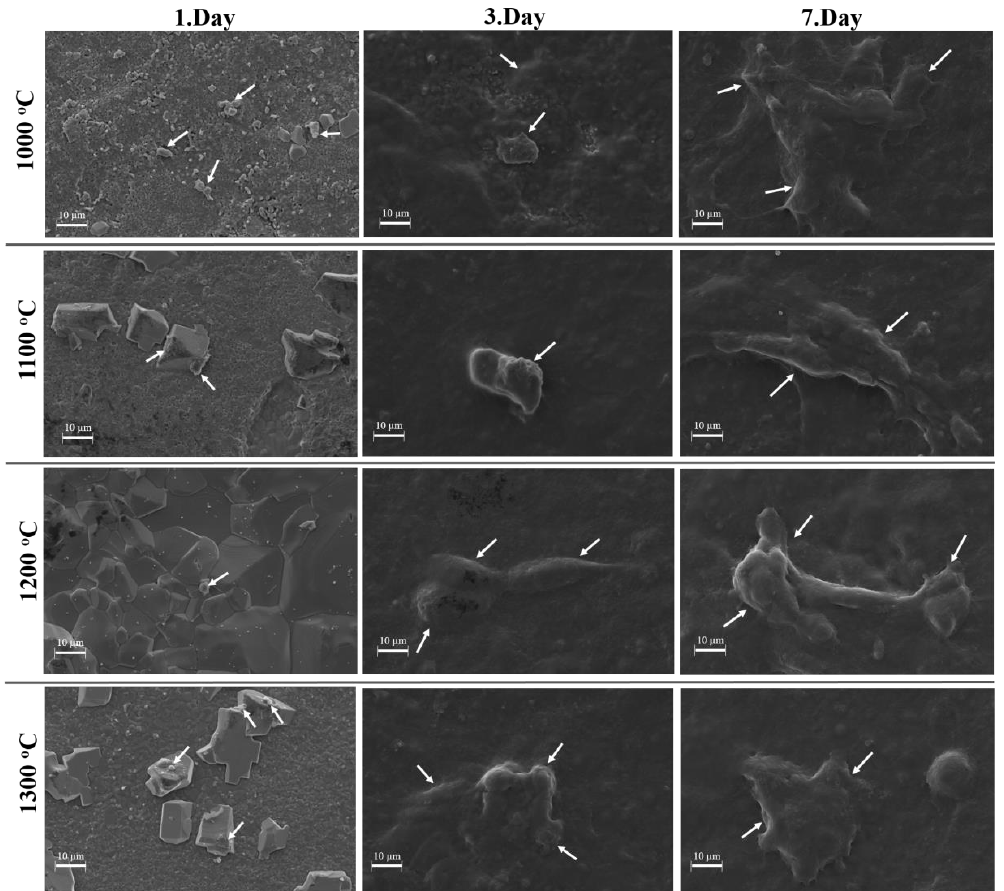
Figure 8. Time-dependent cell attachment and proliferation of sCaP at 1., 3. and 7. days at 1000 °C, 1100 °C, 1200 °C and 1300 °C sintering temperatures in SEM images.